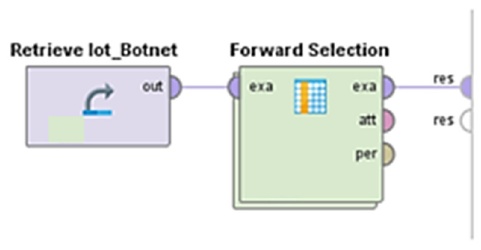
Figure 7. Forward Selection.